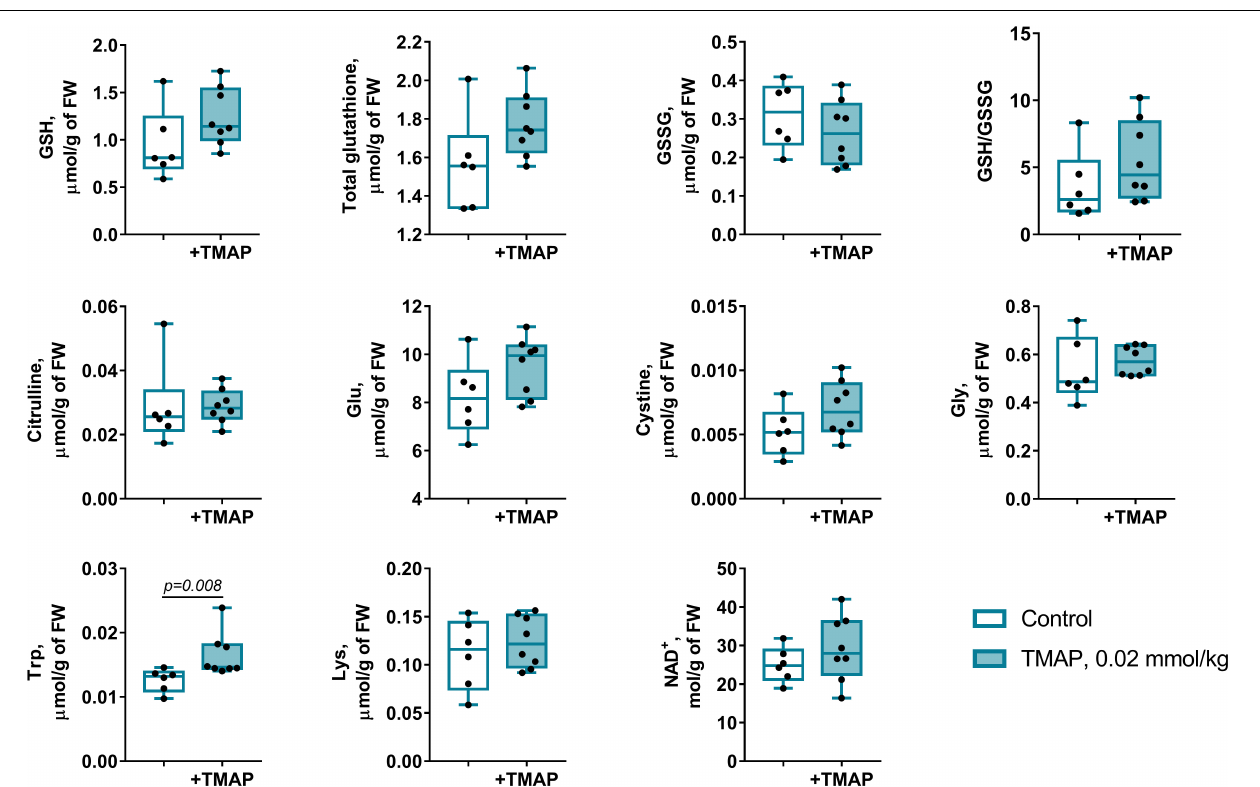
FIGURE 10 | Short-term changes in the redox-state- and OADH-related metabolites in the brain cortex 24 h after a single administration of TMAP. Statistically significant ( p ≤ 0.05) differences between experimental groups are determined by unpaired Mann-Whitney test, with p -values shown on the graphs.